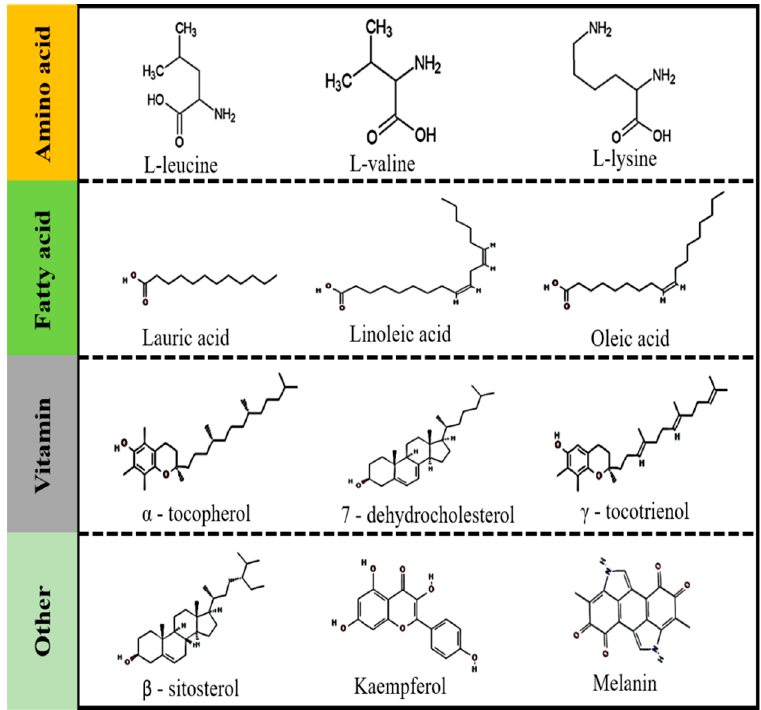
Figure 9. Structures of select chemical constituents present in BSFL.